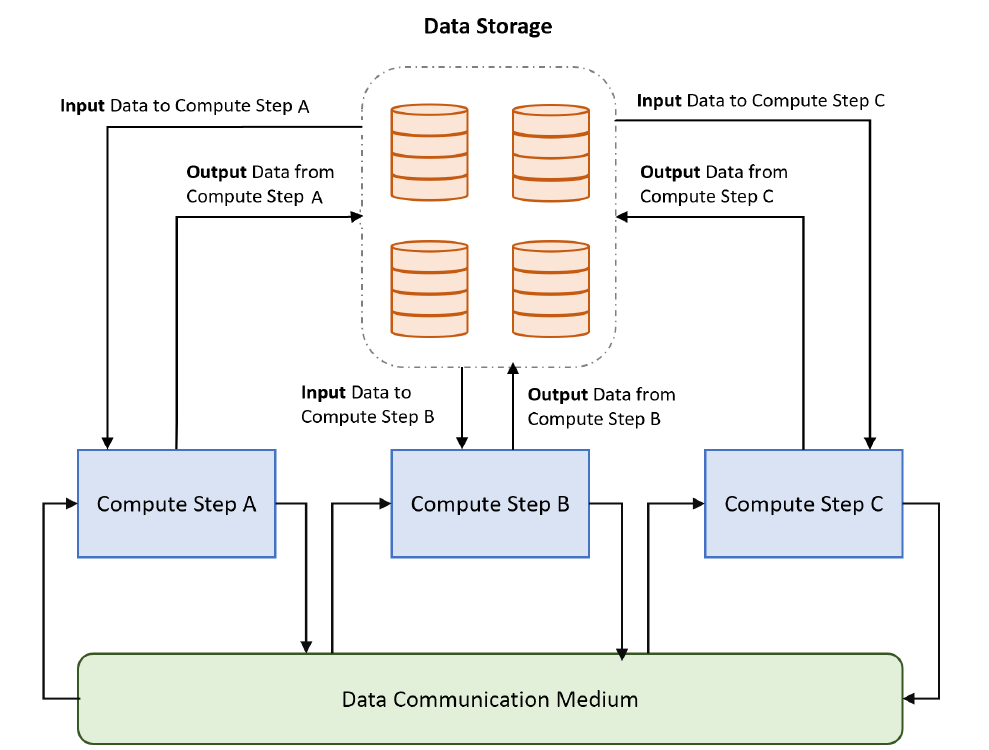
Figure 2. An example pipeline